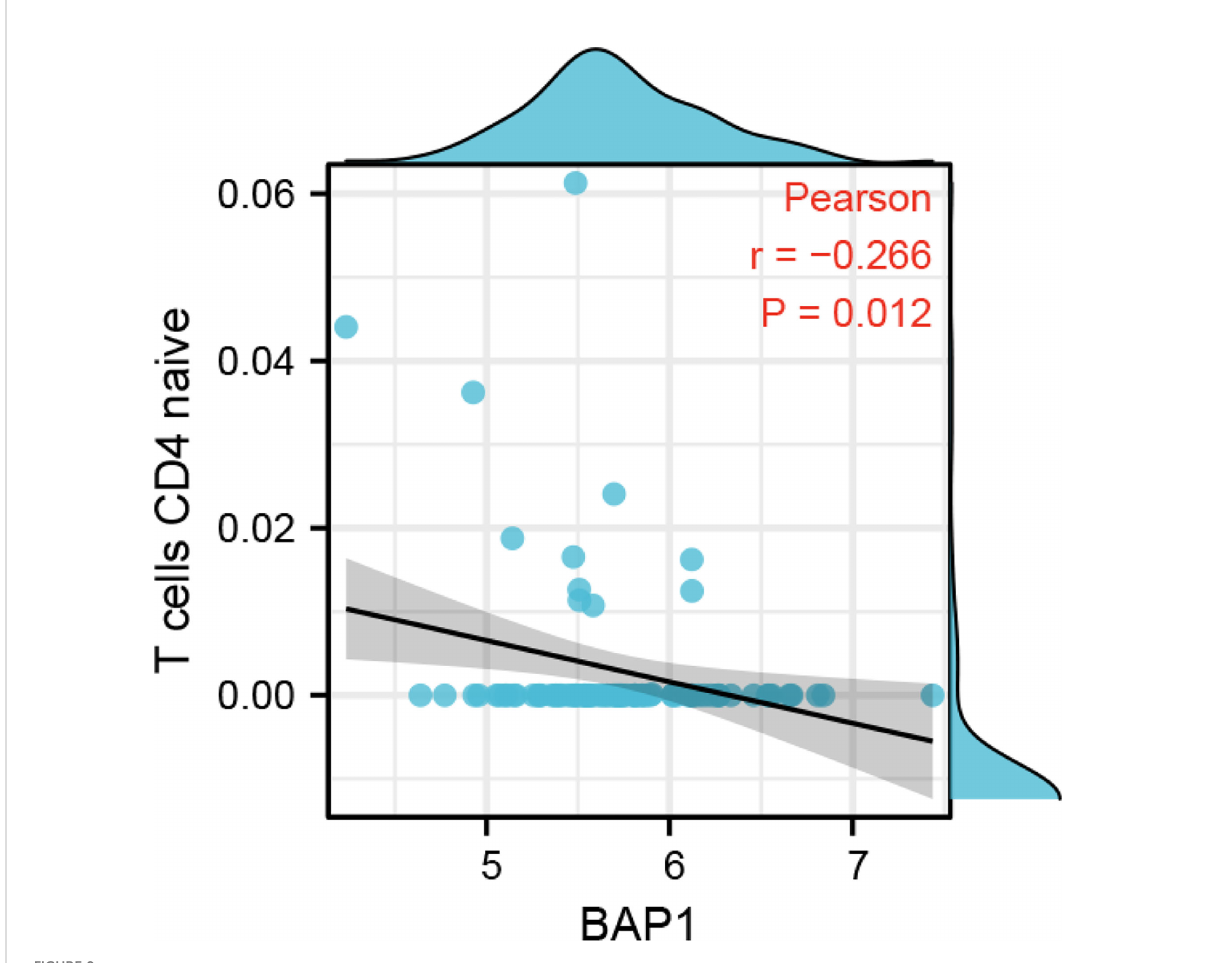
FIGURE 9 The correlation of BAP1 and naïve CD4 T cells in fi ltrated in osteosarcoma